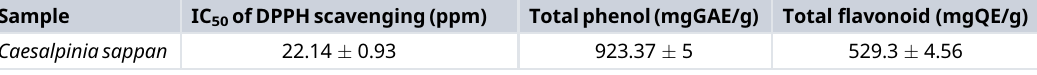
Table 1. Antioxidant activity and total phenol and flavonoid content of the samples. DPPH=2,2 – Diphenyl-1- picrylhydrazyl.